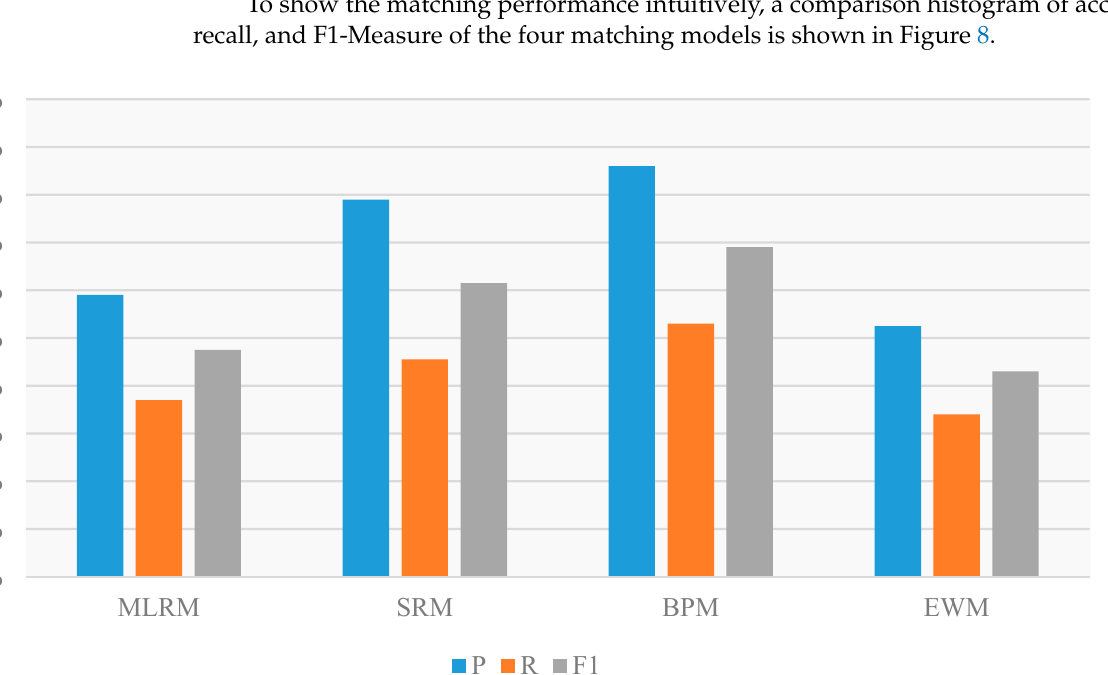
Table 4. Matching results of four matching models.